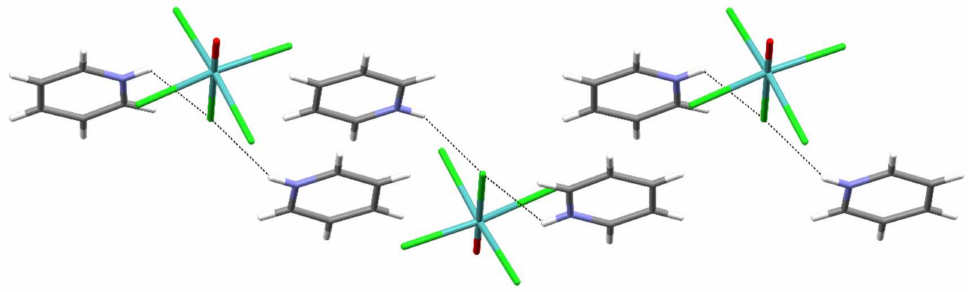
Figure 2. π ··· π stacking of pyridinium cations in (PyH) 2 [MoOCl 5 ]. Dotted lines are the N–H ··· Cl hydrogen bonds.